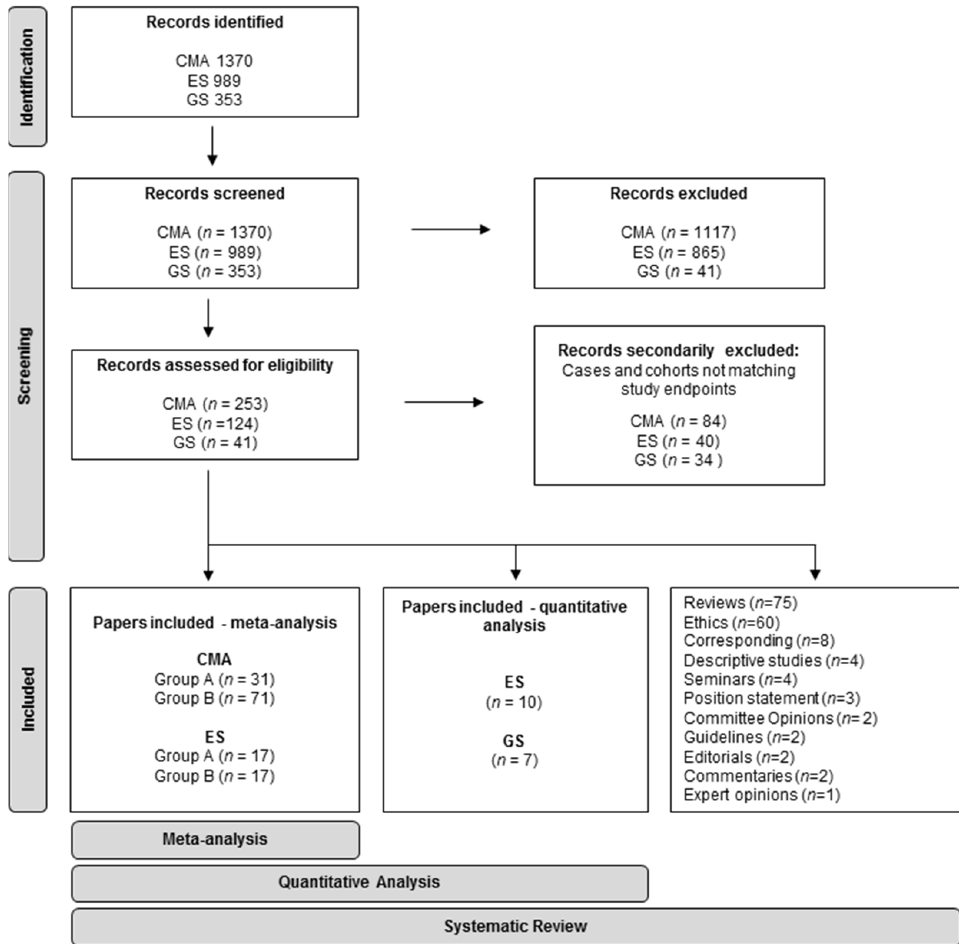
Figure 1. PRISMA flowchart of the systematic review and meta-analysis.